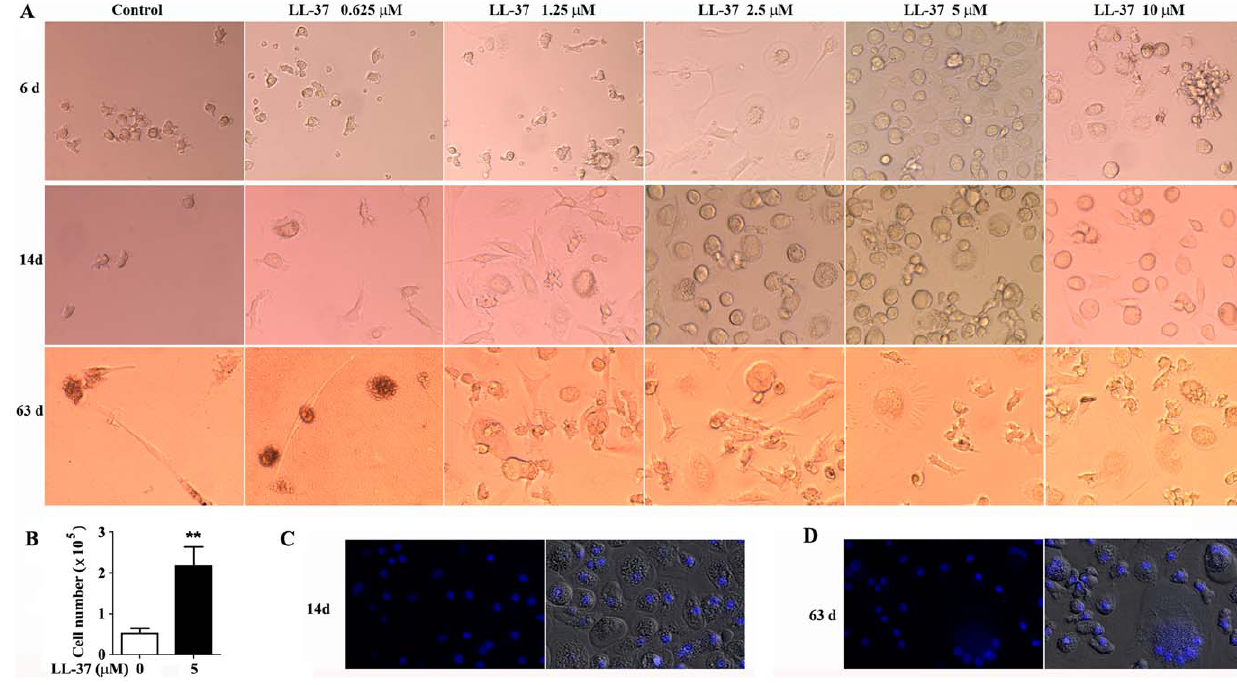
Figure 1. LL-37 induces monocyte differentiation. Negatively isolated monocytes at the concentration of 1 6 10 6 /mL were incubated in RPMI 1460 medium with 10% FBS in the presence or absence of LL-37. A . Cell morphology was shown by phase contrast microscopy (magnification 200 6 ). B . Monocytes were incubated in the presence or absence of 5 m M LL-37 for 6 days. Cells were harvested and counted by hemocytometer. Data (mean 6 SE) was from four independent experiments performed. ** p , 0.01 vs control. C–D . Monocytes treated with 5 m M LL-37 for 14 days ( C ) or 63 days ( D ) were fixed, permeablized, stained with DAPI, and observed by fluorescent microscopy. Multinucleated giant cell formation was found in 63-day LL-37-treated monocytes. Images represent one of four independent